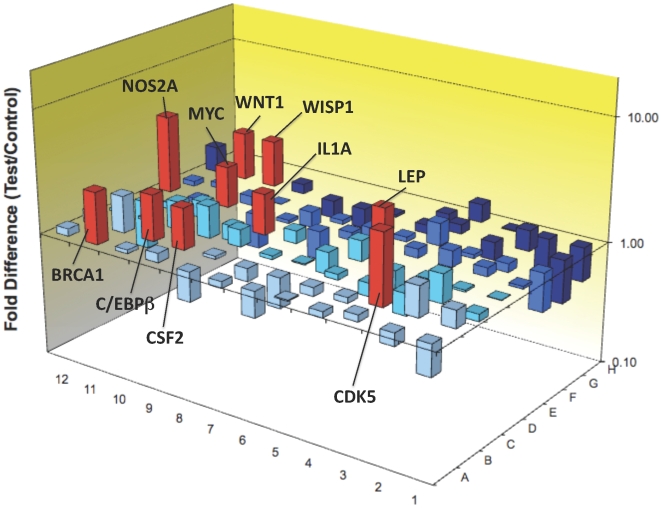
Determination of the genes induced by QA in primary cultures of human neurons using PCR arrays:The 3D histogram shows 84 genes tested in the Pathfinder kit®. Only 10 genes (in red) were significantly increased (expression>2x the control). No genes were significantly decreased.